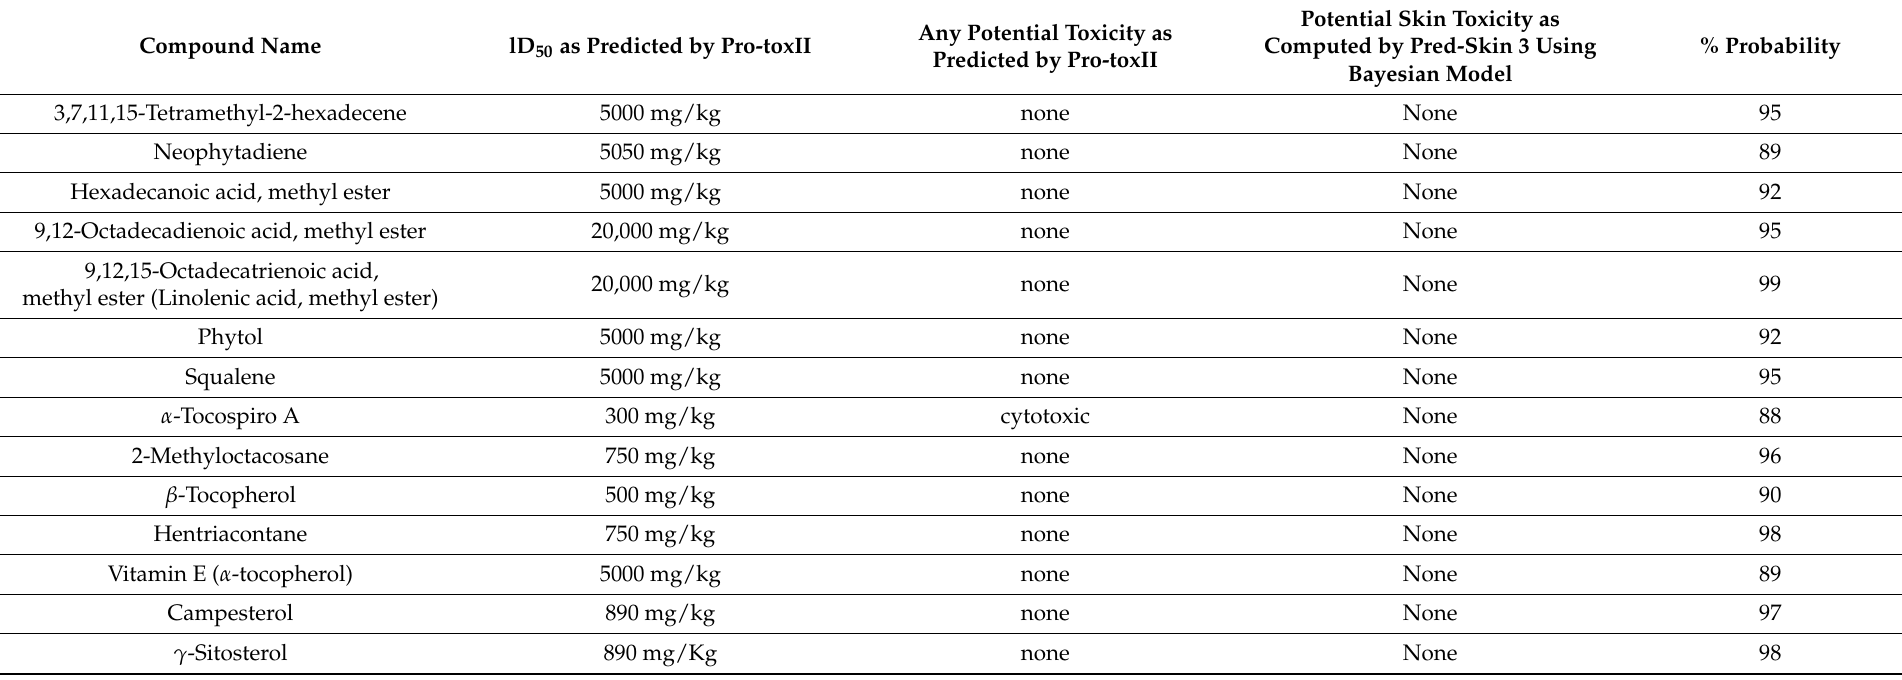
Table 3. In silico toxicity study of compounds identified in